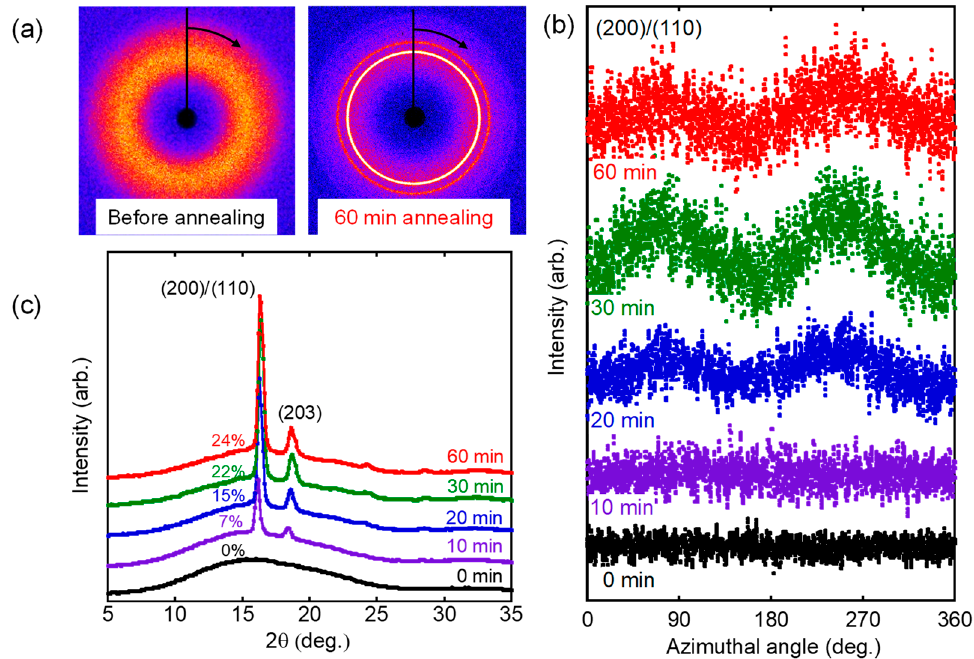
Figure 8. ( a ) 2D-WAXD patterns, ( b ) azimuthal distribution of (200)/(110) plane, and ( c ) 2 θ profiles of the sheared films after annealing at 80 °C for various periods.